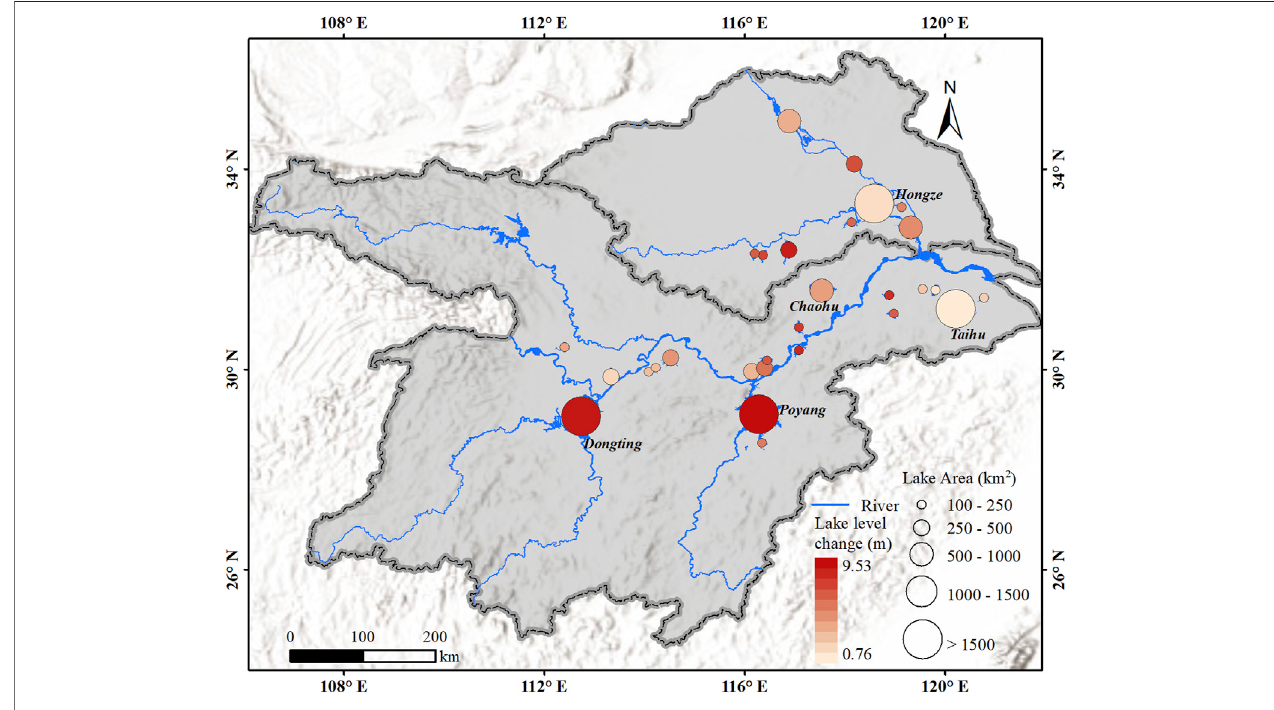
FIGURE 3 | The spatial distribution of seasonal amplitudes of lake water level variations in the